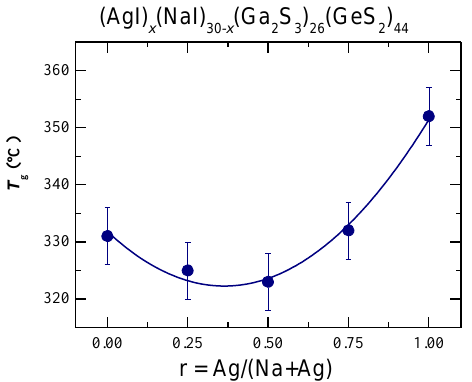
Figure 3. Glass transition temperature, T g , for the (AgI) x (NaI) 30−x (Ga 2 S 3 ) 26 (GeS 2 ) 44 glasses plotted as a function of the silver fraction r = Ag/(Na + Ag). The solid line is drawn as a guide for the eye.